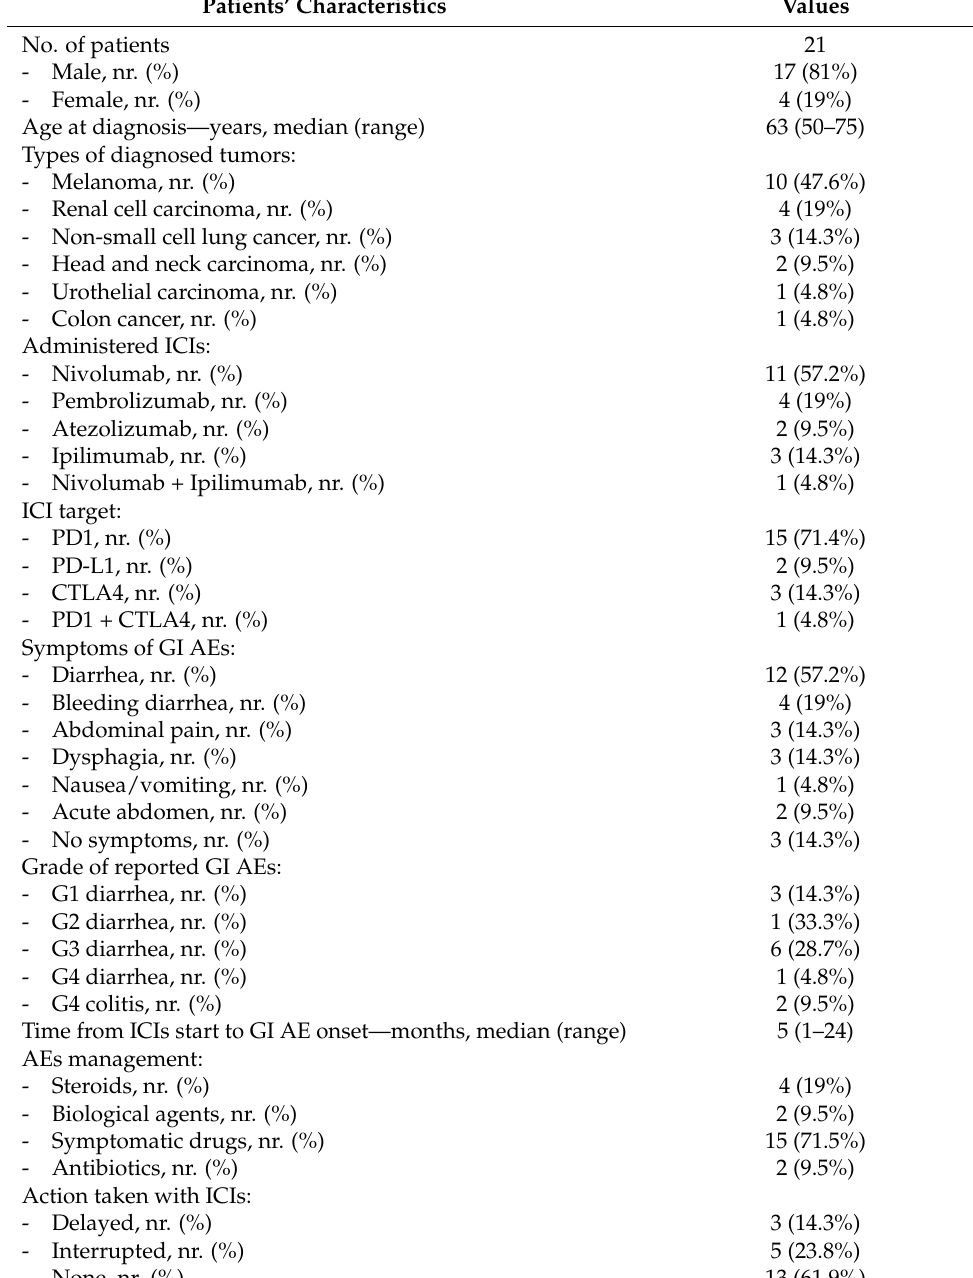
Table 2. Characteristics of the included patients. AE: adverse event; CTLA4: cytotoxic T-lymphocyte- associated protein 4; GI: gastro-intestinal; ICI: immune checkpoint inhibitor; PD1: programmed death 1; PD-L1: programmed death-ligand